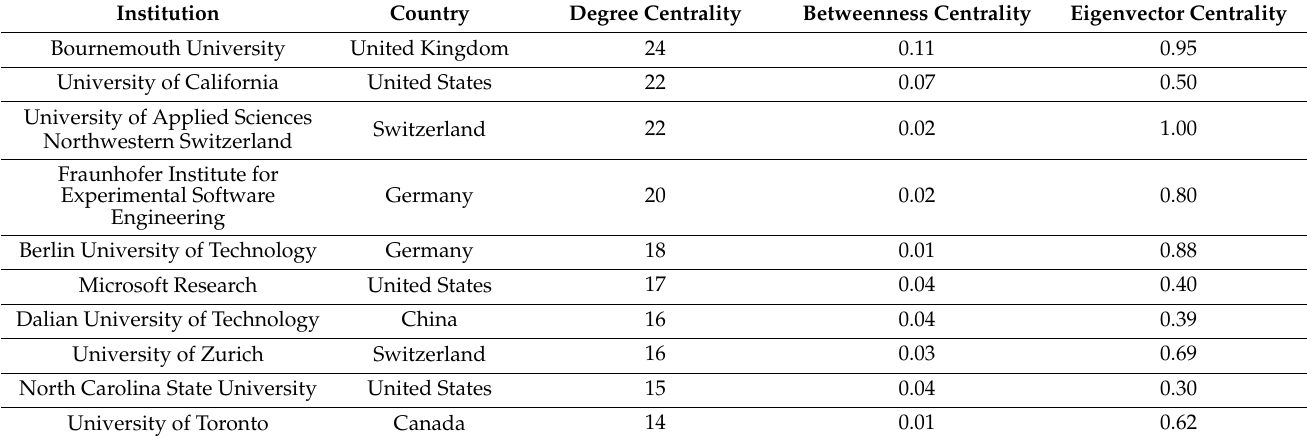
Table 12. Centrality measures of institutions in co-authorship networks.